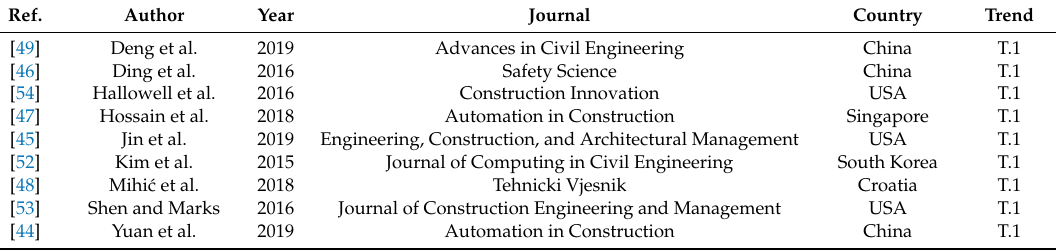
Table A1. List of the selected documents grouped per each trend in alphabetical